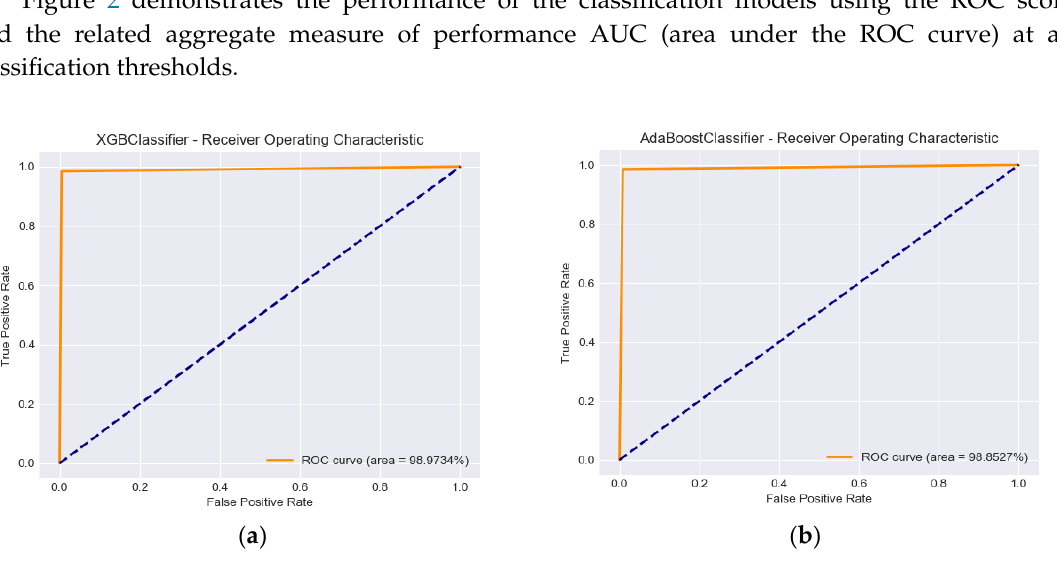
Figure 2. ( a ) XGBClassifier ROC Curve and AUC; ( b ) AdaBoostClassifier ROC Curve and AUC.